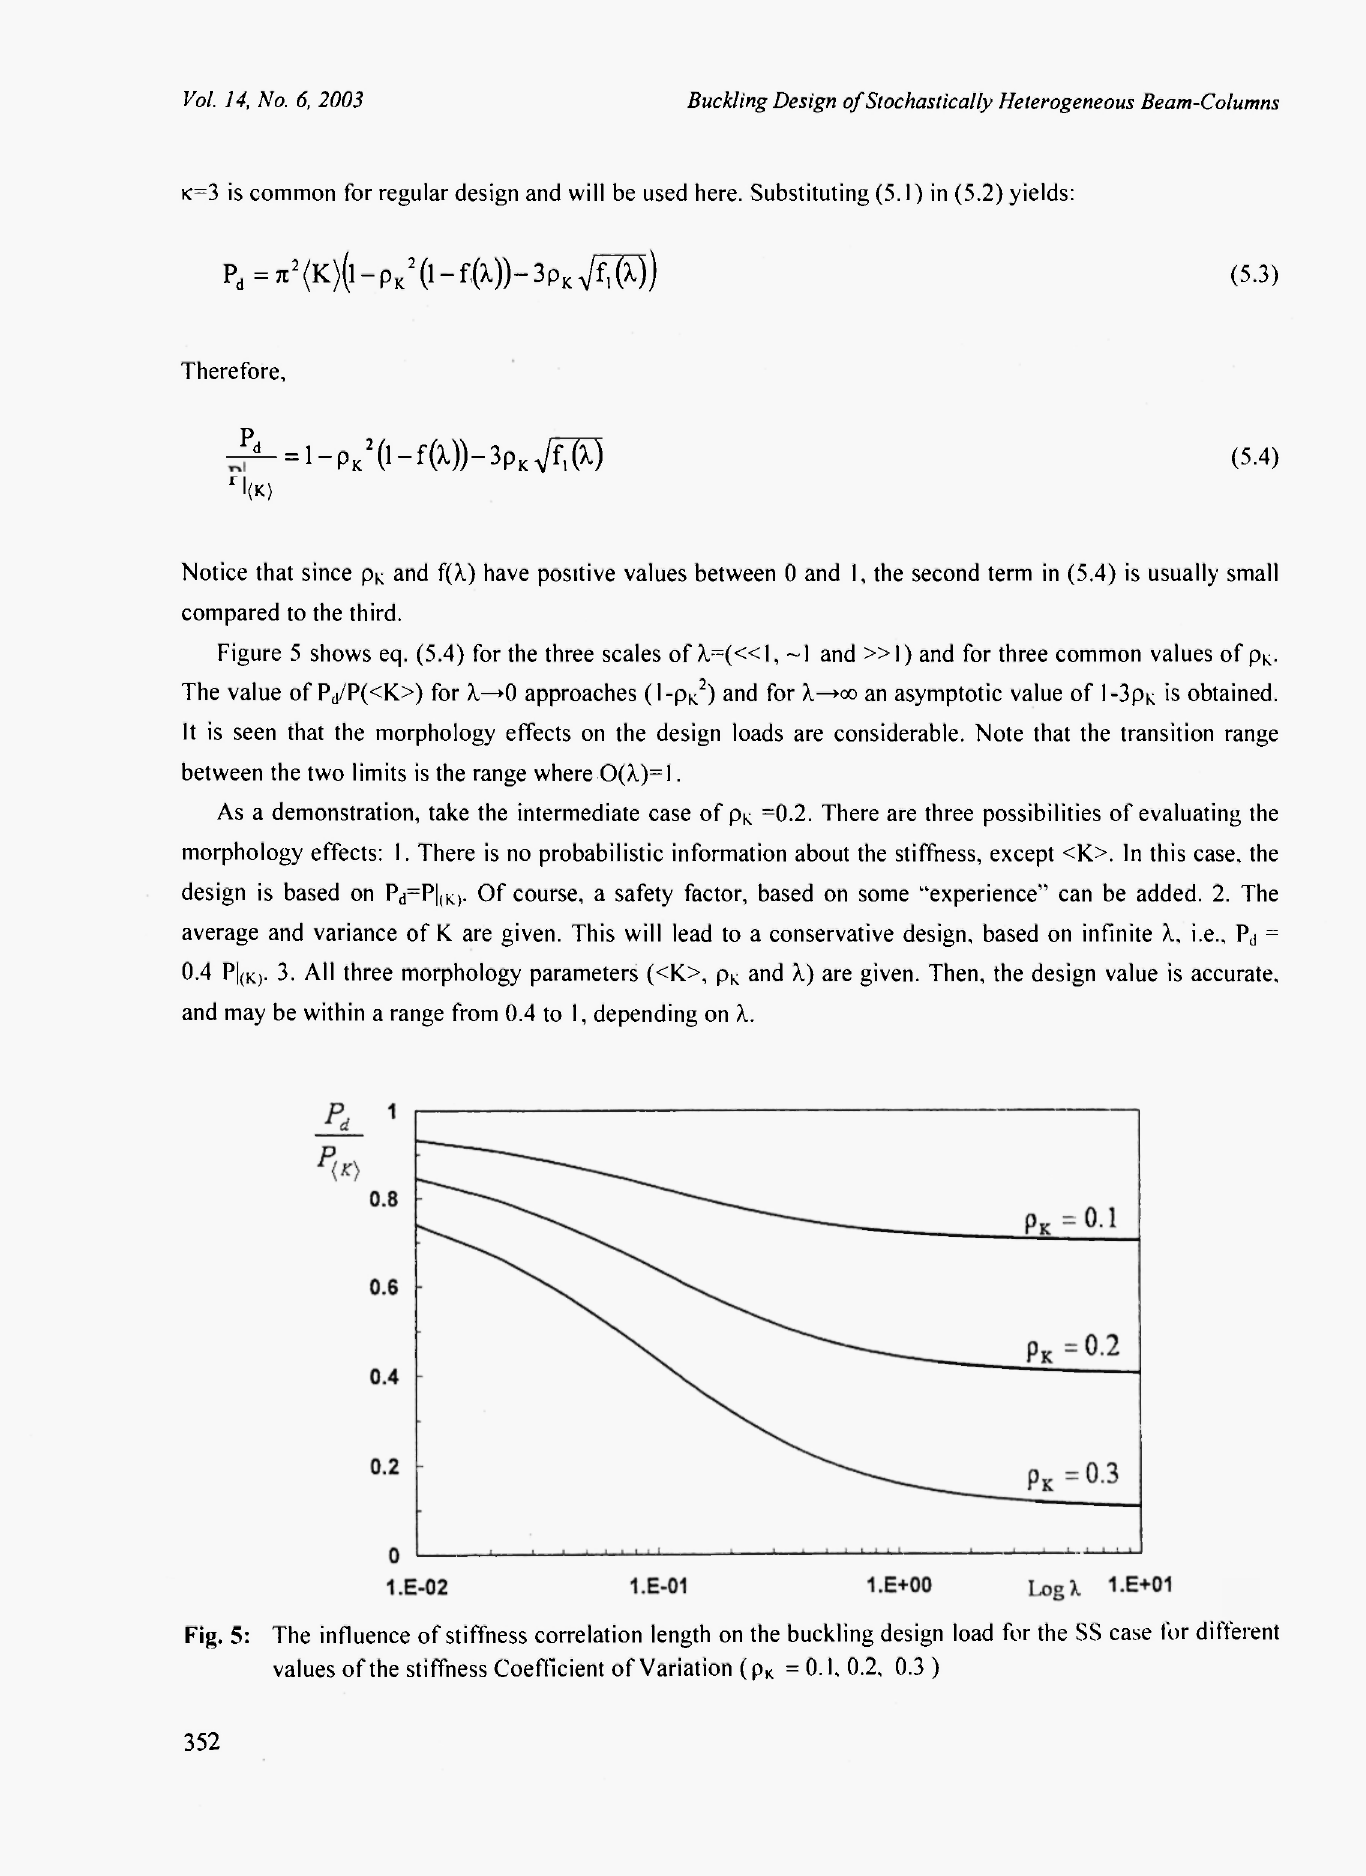
Fig. 5: The influence of stiffness correlation length on the buckling design load for the SS case for different values of the stiffness Coefficient of Variation (p K = 0.1, 0.2, 0.3